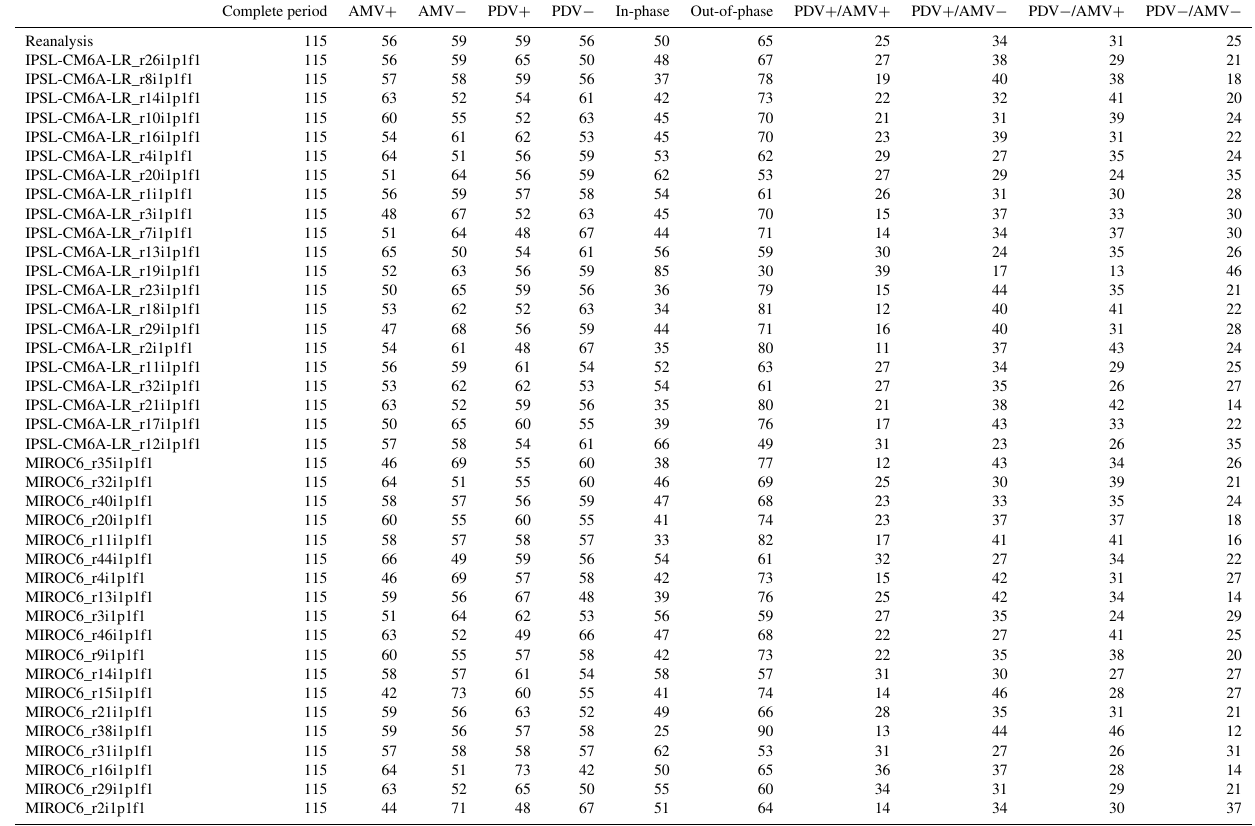
Table A8. Number of years for every regime for reanalysis and CMIP6 simulations